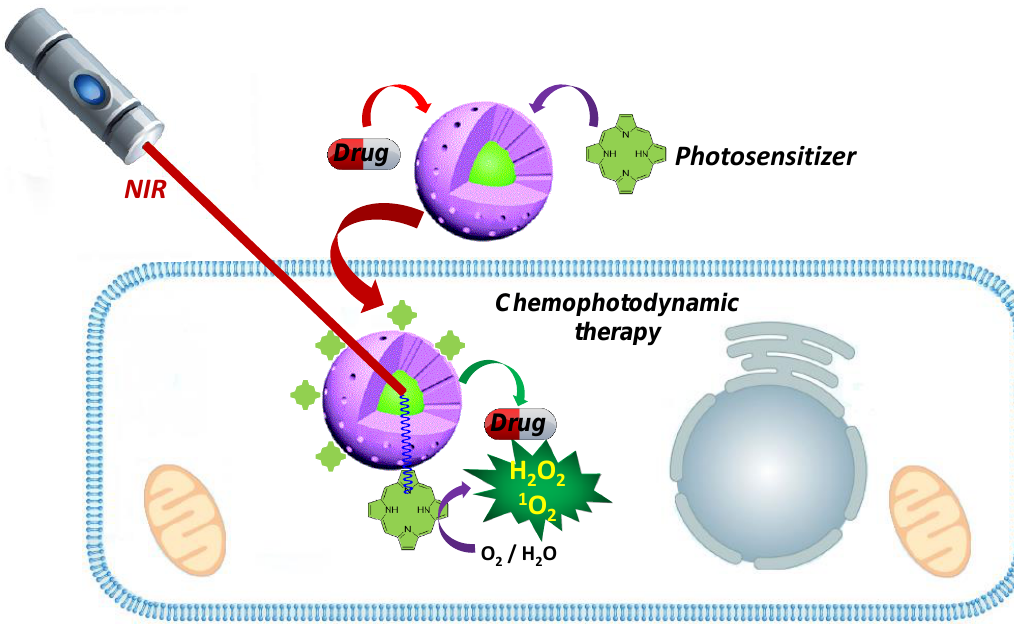
Figure 9. Upconversion-silica-based composites for photodynamic therapy. The internal core of these species is able to transform near infrared radiation into high energetic UV-Vis radiation suitable for exciting most photodynamic sensitizers known to generate oxidative stress-mediated apoptosis.